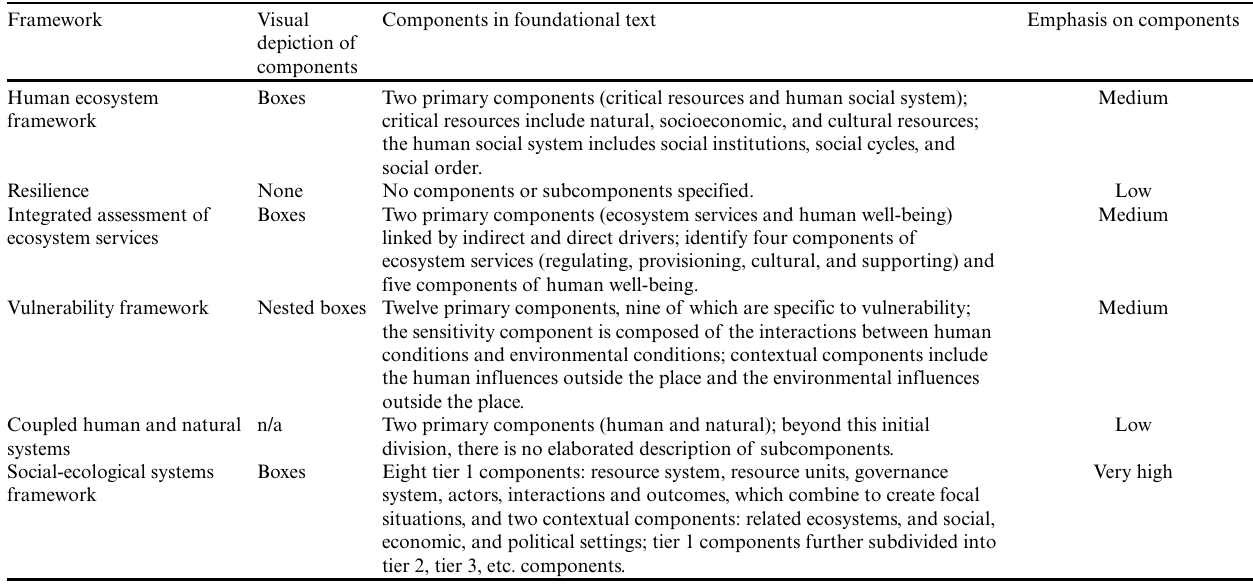
Table 2 . Comparing components in selected socio-environmental (SE)